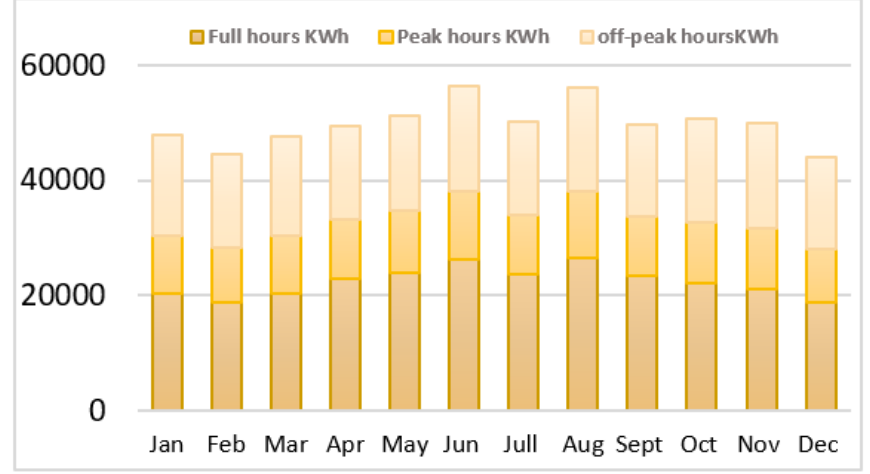
Figure 3. Monthly electrical load of the factory 1—Fez 2021.